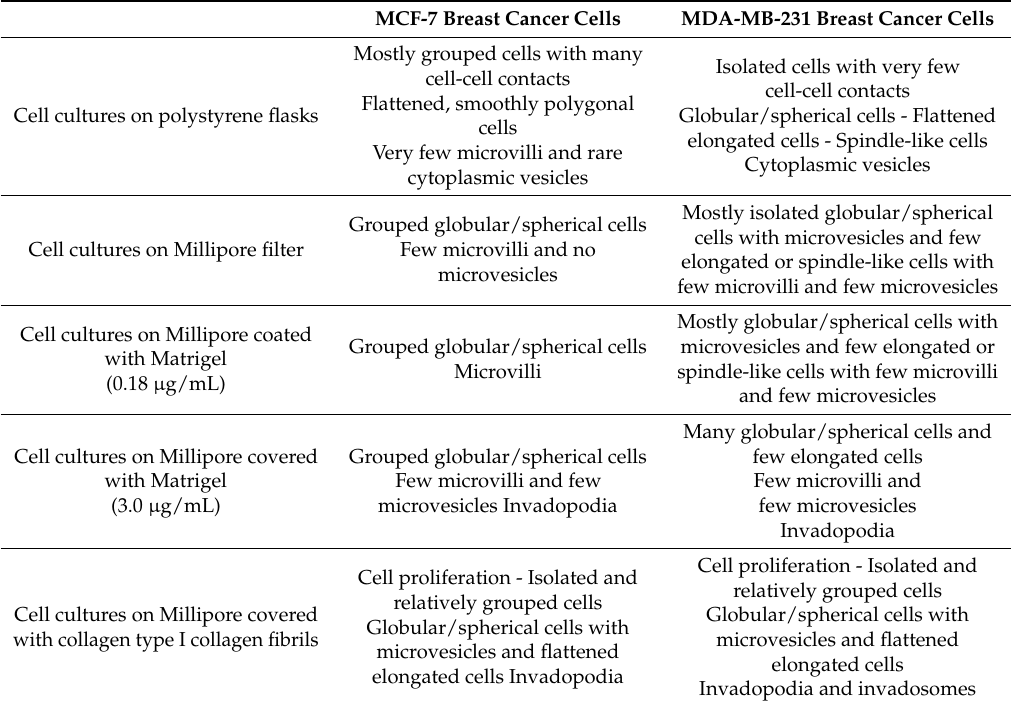
Table 2. The most important similarities and differences of MCF-7 and MDA-MB-231 breast cancer cells cultured in different conditions are